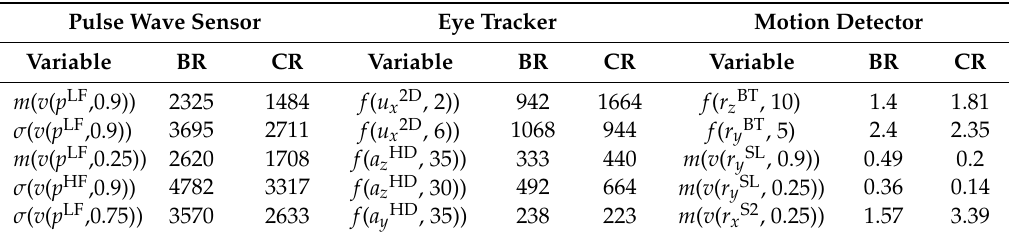
Table 7. Top five of the important variables for predicting the engagement in the generalized model. Pulse Wave Sensor Eye Tracker Motion